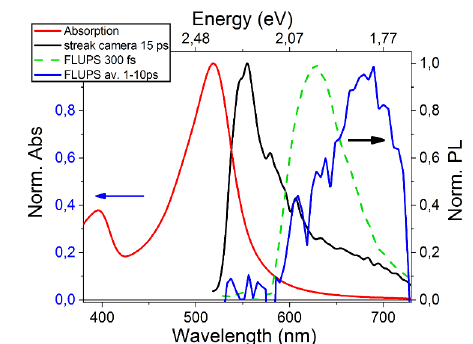
Figure 2: Normalized absorption and time-resolved spectra of the Fe(II) complex presented in fig. 1. Black: 1 MLCT spectrum measured with a SC; Green: 1 MLCT emission through the acc. bandwidth filter of FLUPS; Blue: 3 MLCT emission spectrum averaged 1-10